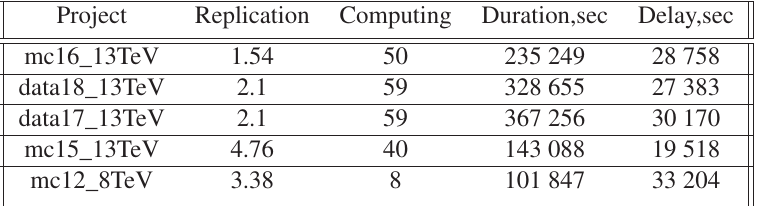
Figure 6: Start time of production and user analysis tasks